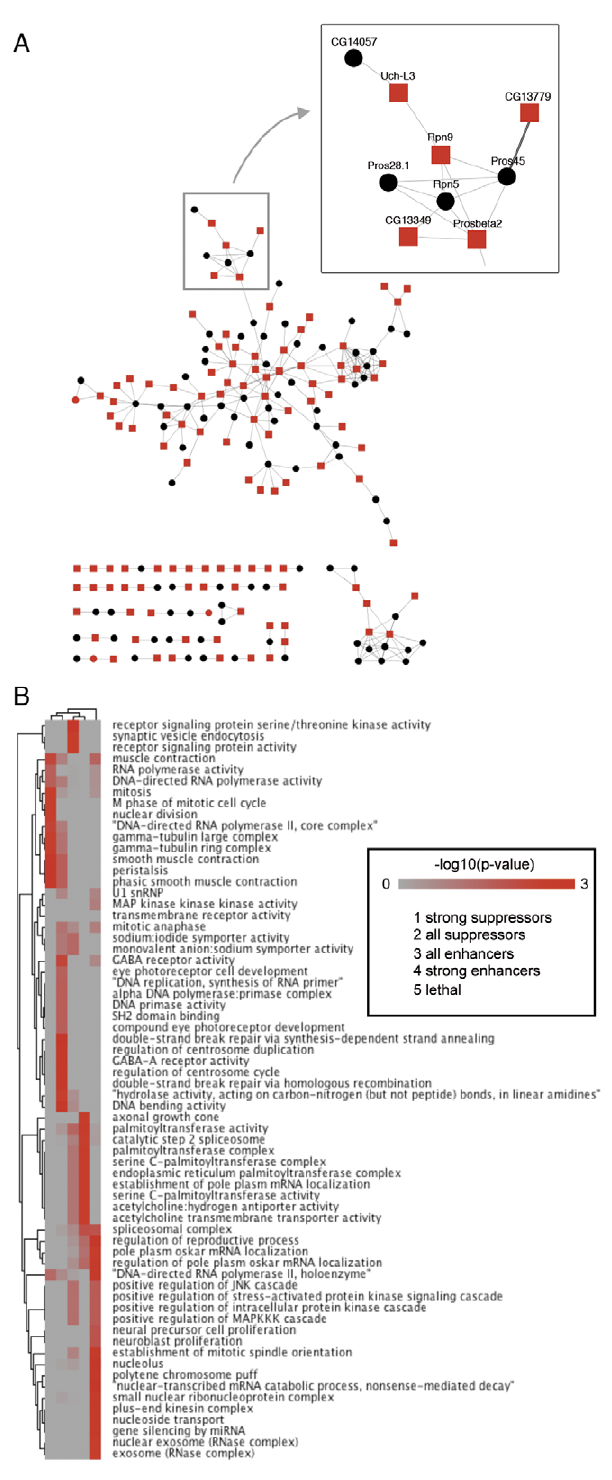
Figure 3. Computational analysis of modifiers of polyQ- induced toxicity. ( A ) Meta-interaction network displaying modifiers of polyQ toxicity. Only candidates causing a robust modification of the REP (red) as well as directly interacting subtle modifiers (black) were retained from an initial network of more than 5 k genes with 20 k interactions [32]. One local cluster of functionally interacting modifiers is highlighted. ( B ) Gene Ontology analysis of these candidate gene groups. Shown are -log 10 (p-value) scores for GO term enrichment for candidate gene groups (horizontal axis, see inset for group